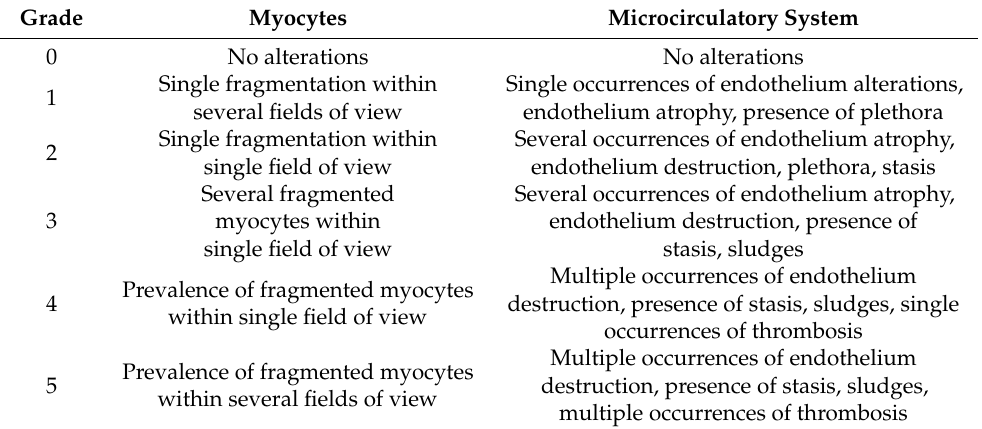
Table 1. Score system for evaluation of alterations in myocytes and microcirculatory system in peripheral